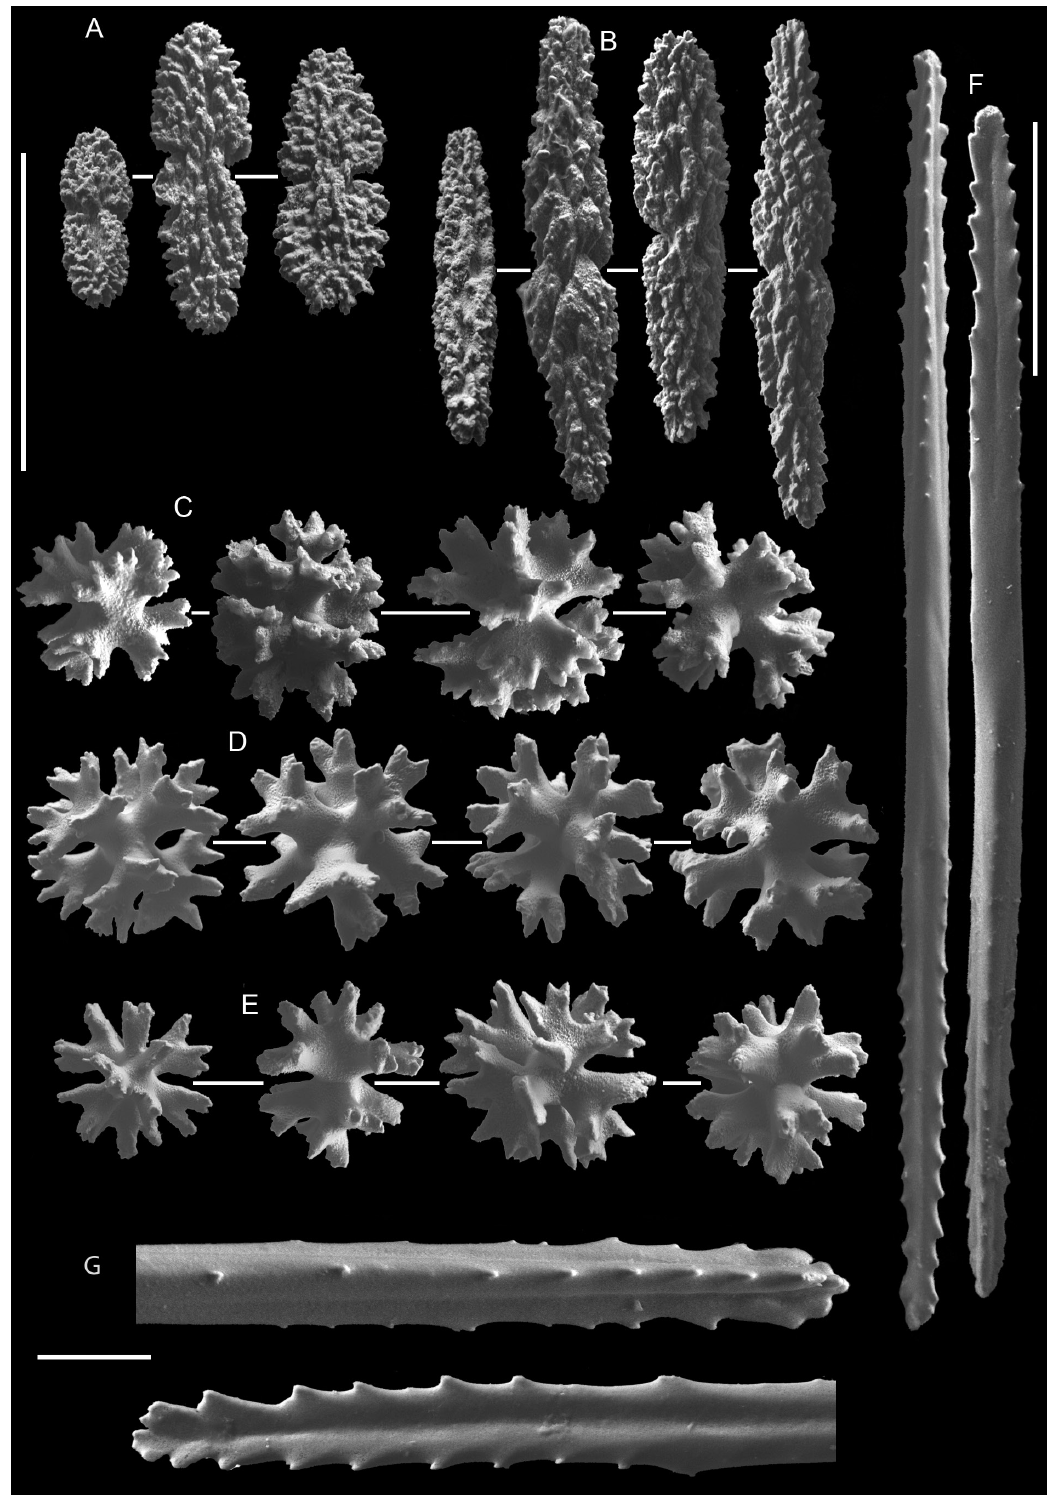
Fig. 3. Heteropolypus annae sp. nov., holotype (MIMB 42493); sclerites from the autozooid pharynx, anthocodiae, and colony body. A . Waisted plates. B . Waisted rods. C . Anthocodiae capstans. D . Capitulum surface capstans. E . Stalk surface capstans. F . Needles. G . Ends of the same needle. Scale bars: A–F = 0.1 mm; G = 0.02